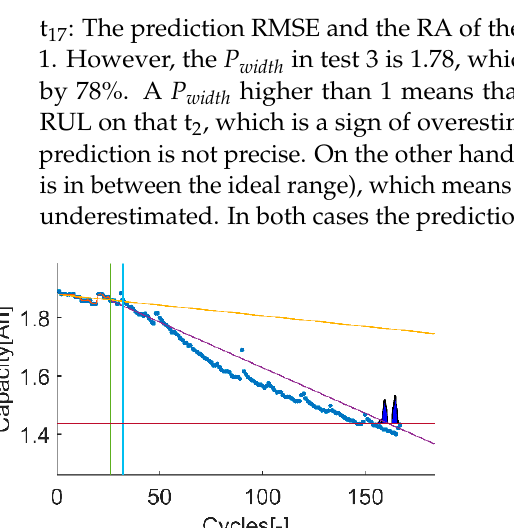
Figure 12. Time-instant figure of test 3 on t 11 .